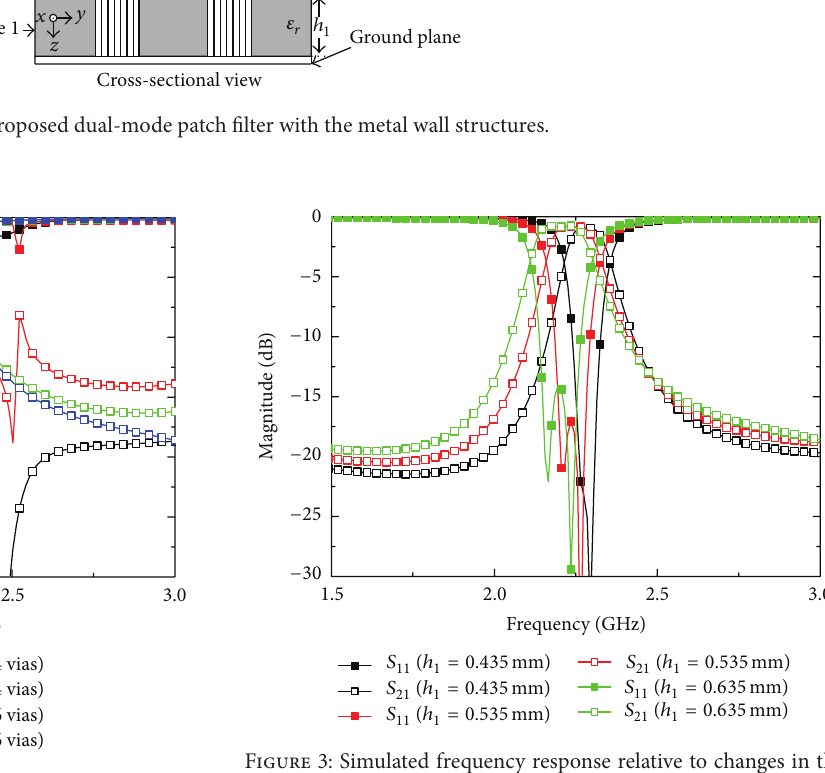
Figure 2: Simulated frequency response relative to changes in the number of the vias.